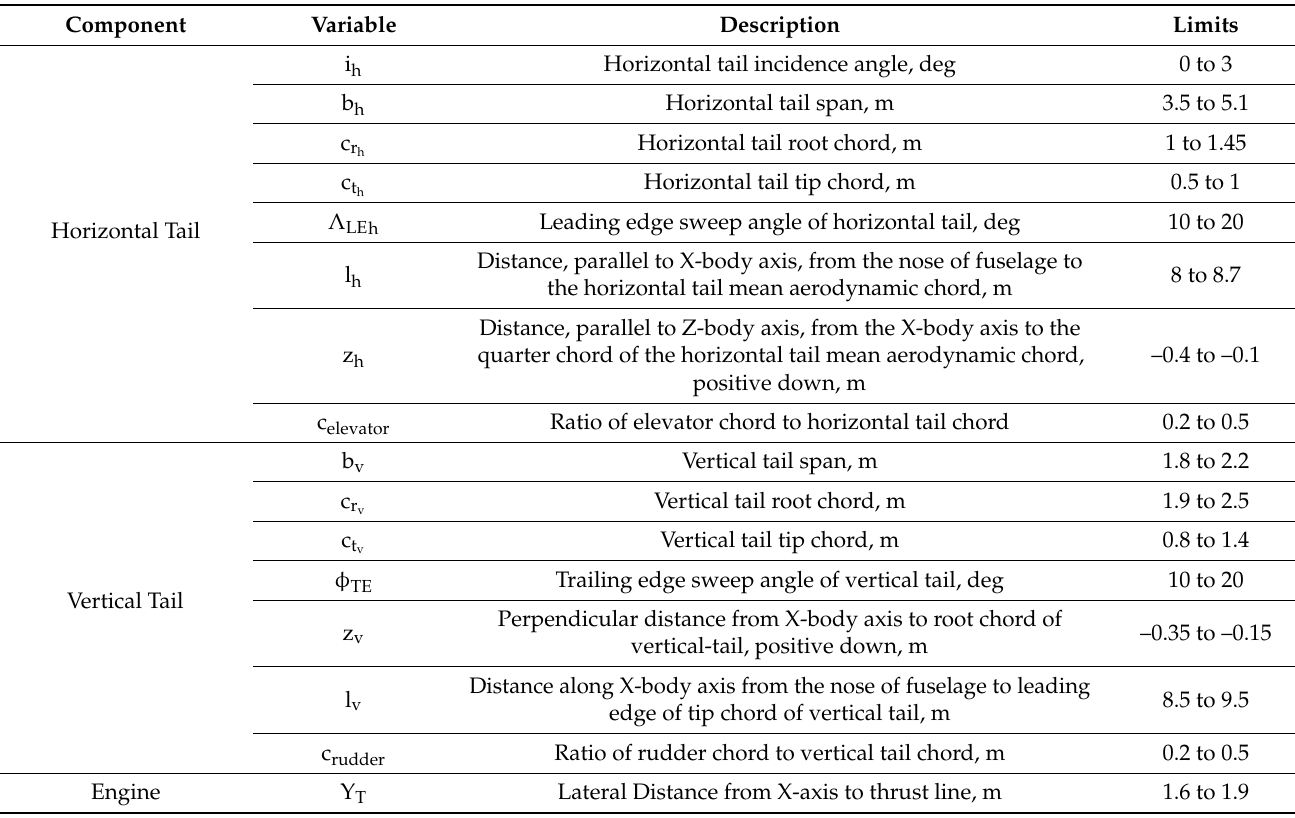
Figure 6. Aircraft design variables used to size the empennage package and the graphical. Table 3. Aircraft design variables and their descriptions for empennage